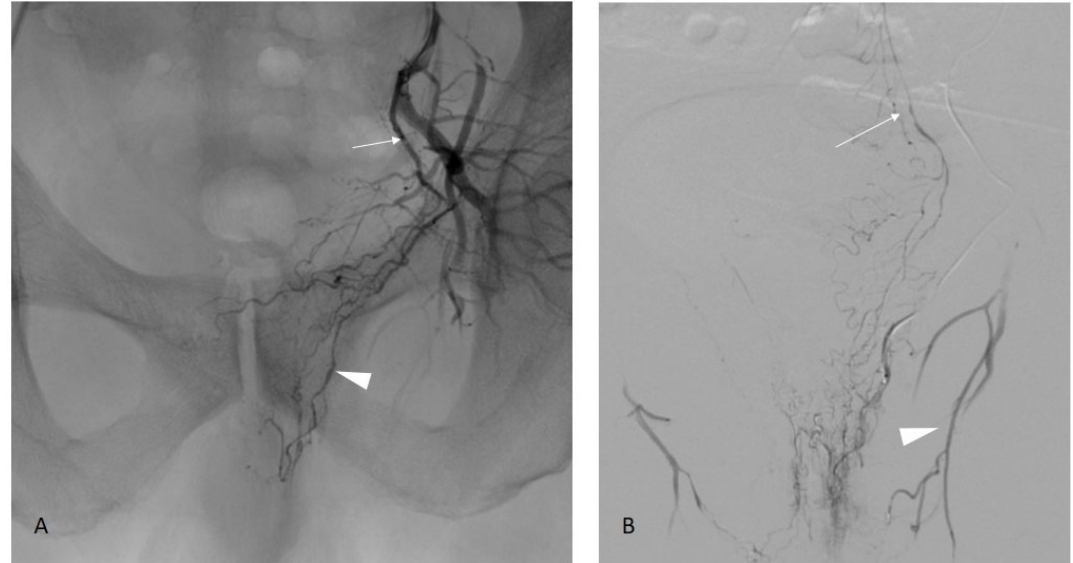
Figure 5. Prostate artery connection with the middle rectal artery. Image ( A ): Iliac angiography demonstrating a vesico-prostatic trunk (arrow) with collateral in the direction of the rectum (arrowhead). Image ( B ): Supraselective angiography in the middle rectal artery confirming the opacification of the rectum and connection with the superior rectal artery (arrow) arising from the inferior mesenteric artery. Note another shunt with the obturator artery (arrowhead).